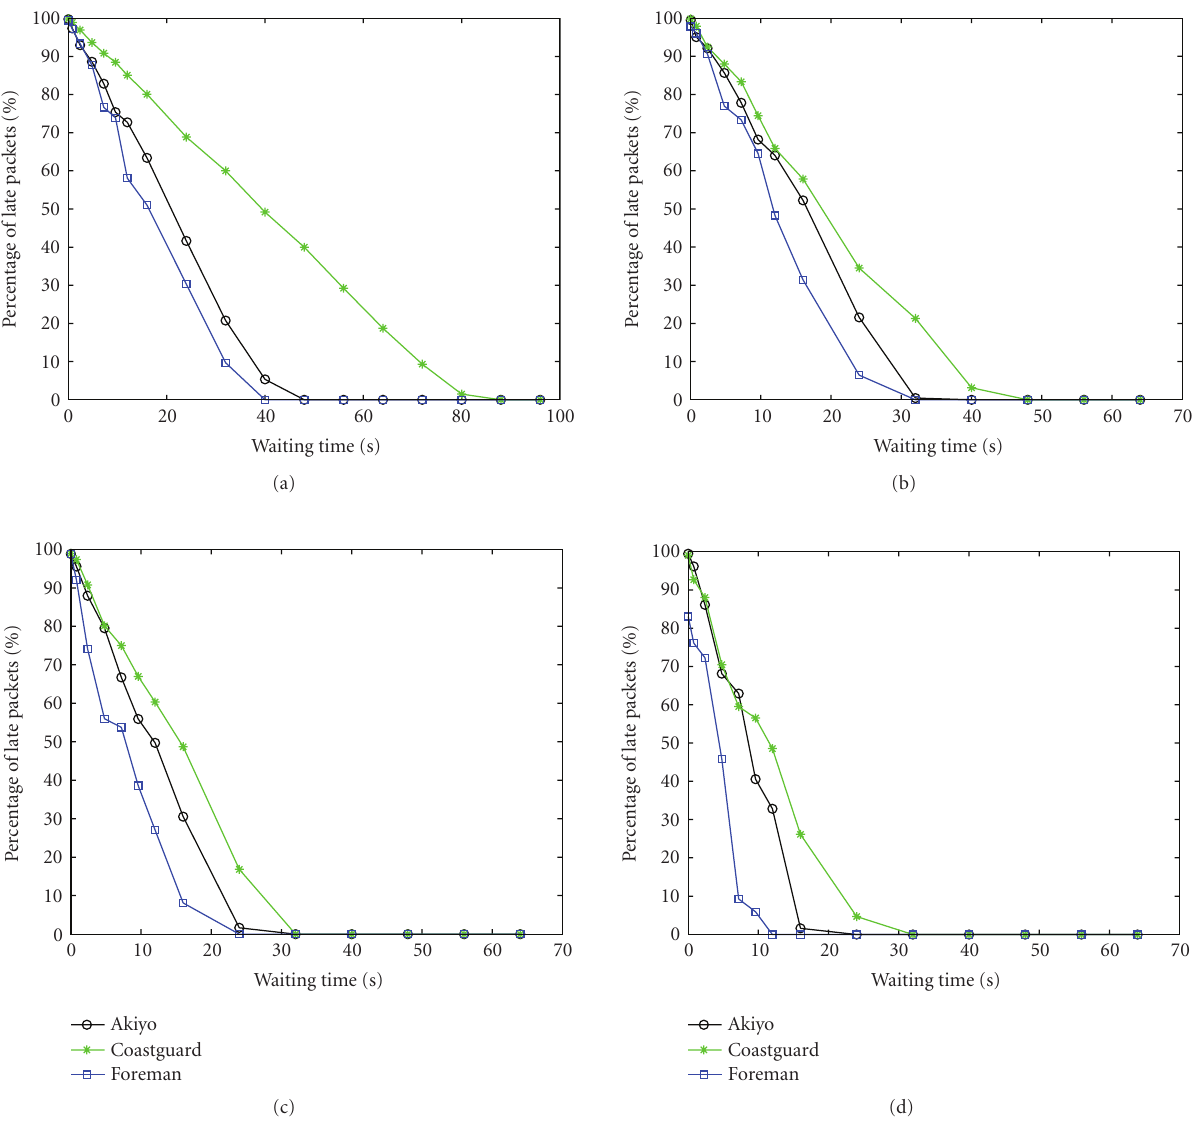
Figure 7: Percentage of late packets as a function of streaming bu ff er length (in seconds); (a) 0% bandwidth safety margin, (b) 1% bandwidth safety margin, (c) 2% bandwidth safety margin, (d) 3% bandwidth safety margin. The bit rates of Akiyo, Coastguard, and Foreman are 192, 160, and 256 Kbps,